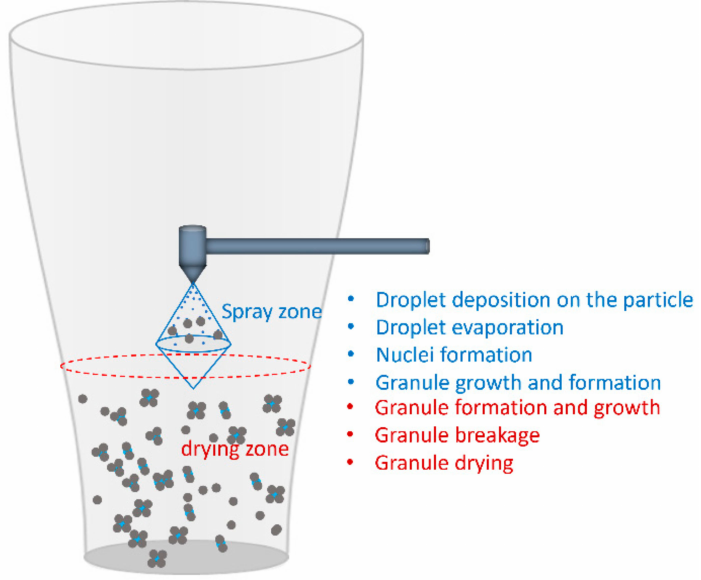
Figure 8. Indication of the spray and drying zones in a typical fluid